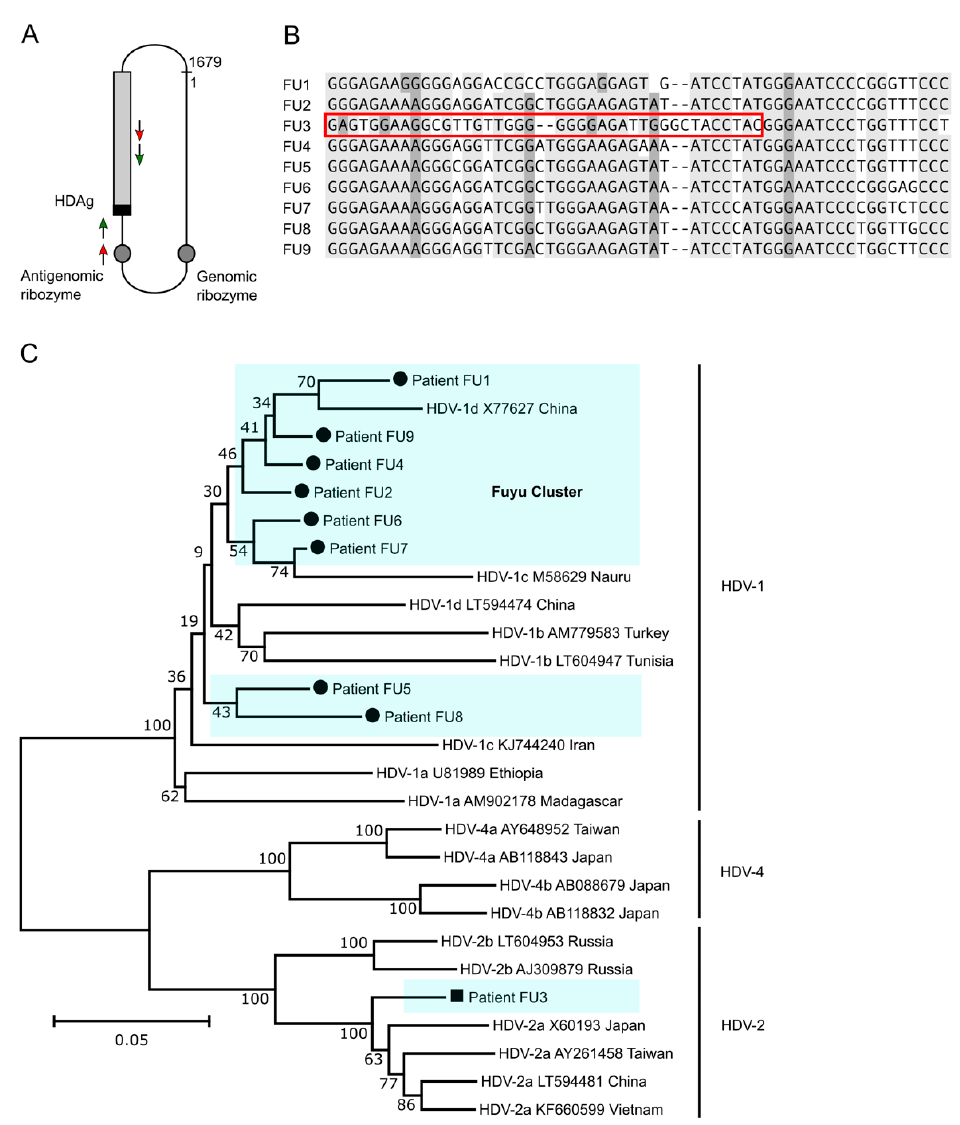
Figure 5. HDV genotyping in a Chinese high-risk population (Fuyu, Jilin province) known for abundant needle sharing during IVDU. ( A ) Scheme of primer binding sites for PCR and Sanger sequencing in the HDV genome. Purified viral RNA from patient serum originating from a high-risk population in the remote northeastern Chinese town, Fuyu (Jilin province), was reverse transcribed using the SuperScript IV reverse transcriptase (Invitrogen, Carlsbad, USA) and cDNA products were amplified by PCR using customized primers p890 and p1265 (red arrows). PCR products were sent for Sanger sequencing. When no sequence data could be obtained, PCR products were further amplified via nested PCR using an internal primer pair (p928 and p1210, green arrows). Grey rectangle: small HDAg reading frame; black rectangle: 19 amino acid extension in large HDAg; grey circles: genomic and antigenomic ribozymes. ( B ) Alignment of nine sequencing results. Light gray: highly conserved; dark grey: conserved showing similarity; white: variable. ( C ) Phylogenetic tree of HDV genomes in nine patients from Fuyu and reference strains. Numbers on the branches represent bootstrap percentages after 1000 replications. The scale bar corresponds to a phylogenetic distance of 0.05 nucleotide substitutions per site.